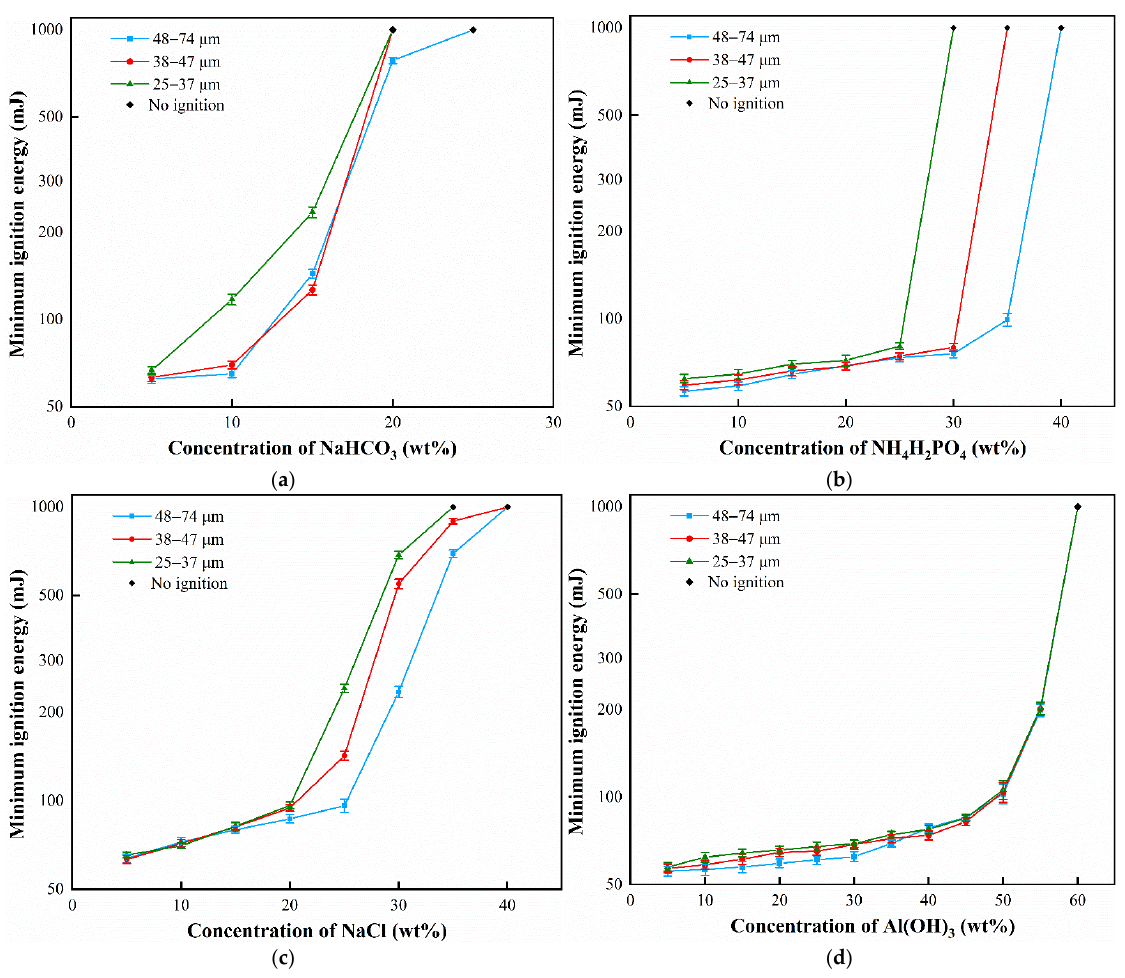
Figure 3. Effect of four inert powders with different particle sizes on sucrose MIE. ( a ) NaHCO 3 ; ( b ) NH 4 H 2 PO 4 ; ( c ) NaCl; ( d ) Al(OH) 3 .